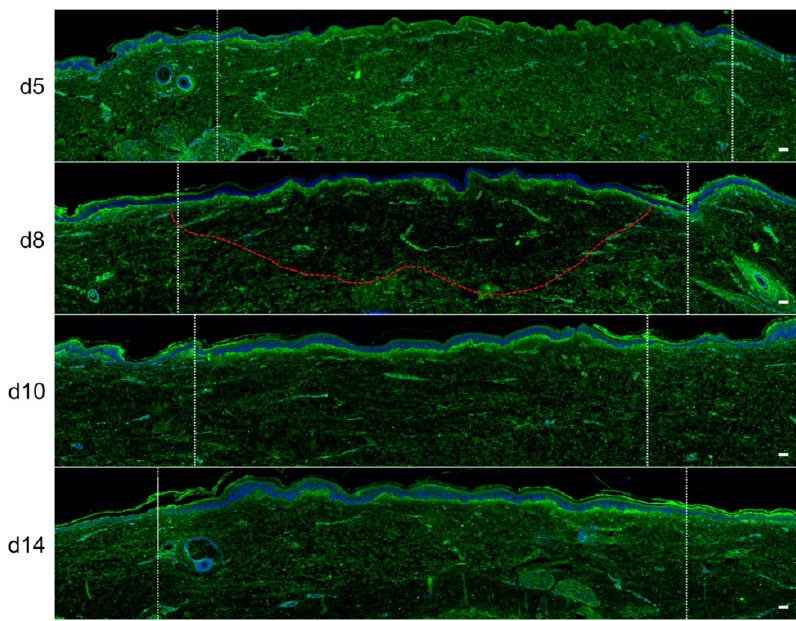
Figure 5. Kinetics of procollagen III synthesis in ex vivo cultured human skin explants submitted to 10 s long experimental injury. Immunostaining of procollagen III was performed on human skin explants harvested at different time points post burn (days 5, 8, 10, and 14). No significant change was observed on day 5. On day 8, a decreased intensity in procollagen III staining (area delimited by a red dotted line) was observed in the dermal area adjacent to the burnt epidermis. On day 10, this decrease in procollagen III staining intensity was less pronounced but still present until it returned to baseline levels on day 14. Experiments were performed on skin explants derived from three donors. White dashed lines delineate the burnt area. Scale bar: 100 µm.